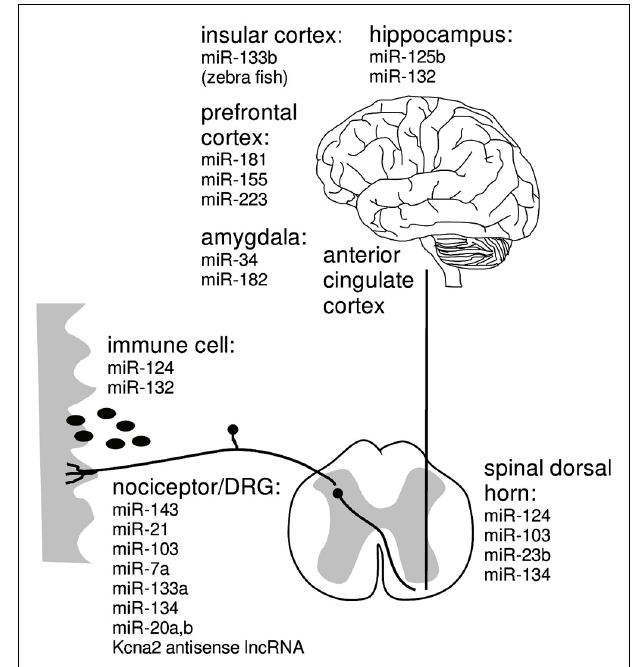
FIGURE 2 | miRNA that may be causally associated with maintained neuropathic pain in immune cells (Shaked etal., 2009; Soreq andWolf, 2011; Ponomarev etal., 2013), nociceptors/DRG (Zhao etal., 2010, 2013; TamTam etal., 2011; Ni etal., 2012; Sakai and Suzuki, 2013), spinal cord (Brandenburger etal., 2012; Favereaux etal., 2011; Im etal., 2012; Ni etal., 2012;Willemen etal., 2012), insular cortex (Sanchez-Simon etal., 2010), amygdala (Meerson etal., 2010; Haramati etal., 2011; Griggs etal., 2013), prefrontal cortex (Poh etal., 2011), hippocampus (Edbauer etal.,